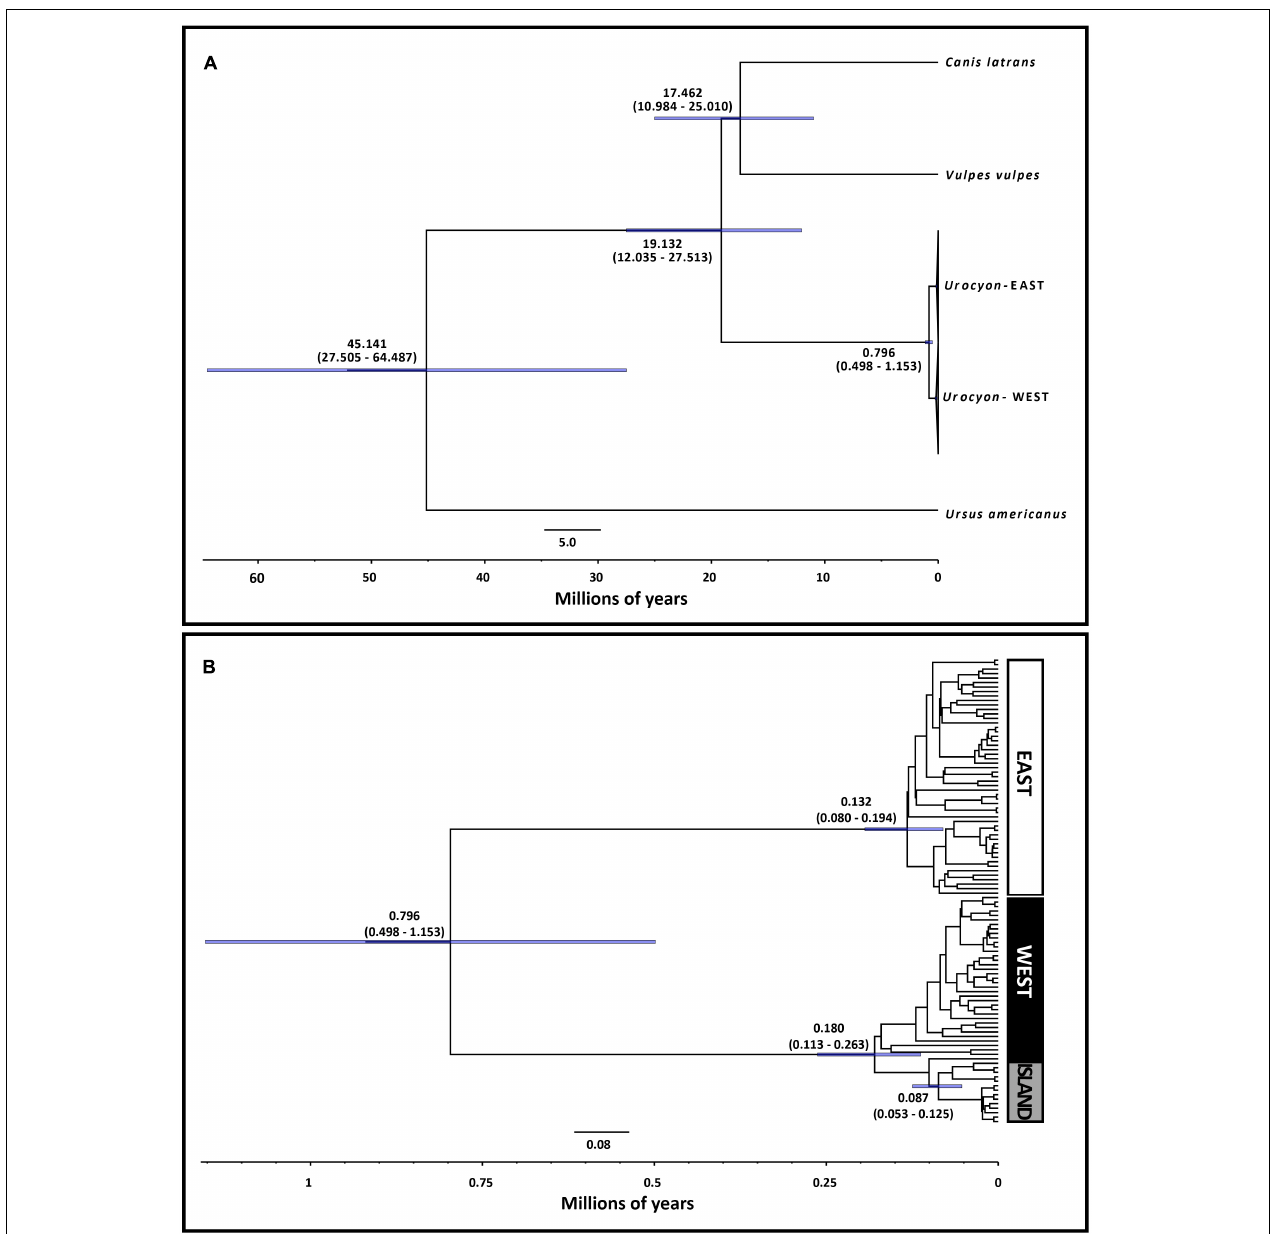
FIGURE 4 | Estimated divergence time of eastern and western lineages of Urocyon based on BEAST analysis of mitochondrial genomes (D-loop omitted) for 104 Urocyon samples and 3 outgroups. (A) Full tree with East and West Urocyon clades collapsed and (B) Urocyon subtree. Blue bars on nodes and corresponding values in parentheses indicate the 95% highest probability density (HPD) interval for the mean time